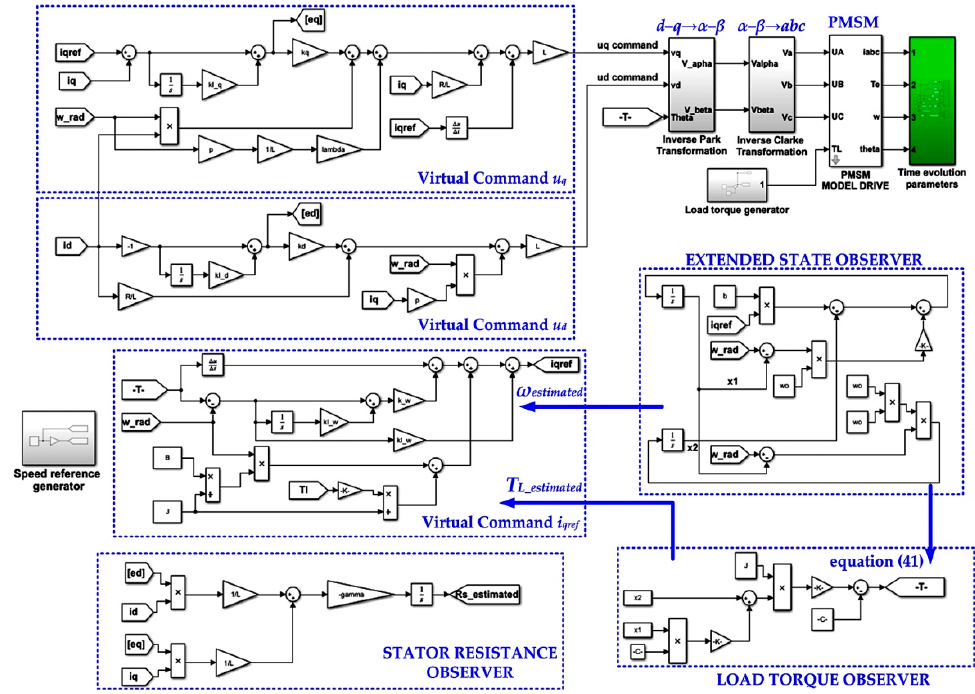
Figure 16. Block diagram for the implementation in MATLAB/Simulink of the sensorless control of the PMSM based on backstepping-PSO controller and ESO-type observer.